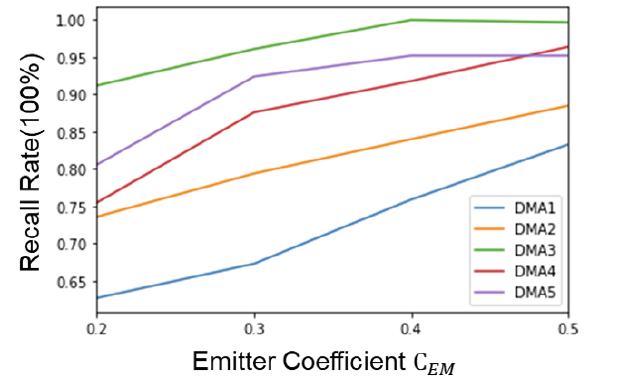
Figure 9. Recall rates of different district metering areas